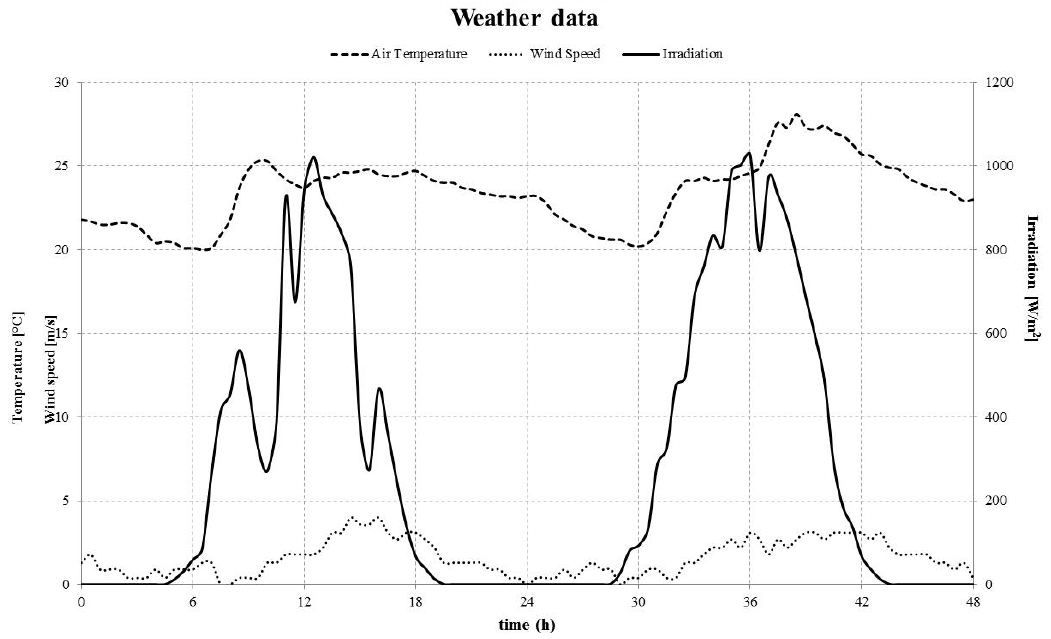
Figure 9. Trends of climatic parameters in Palermo, 26–27 June 2010.